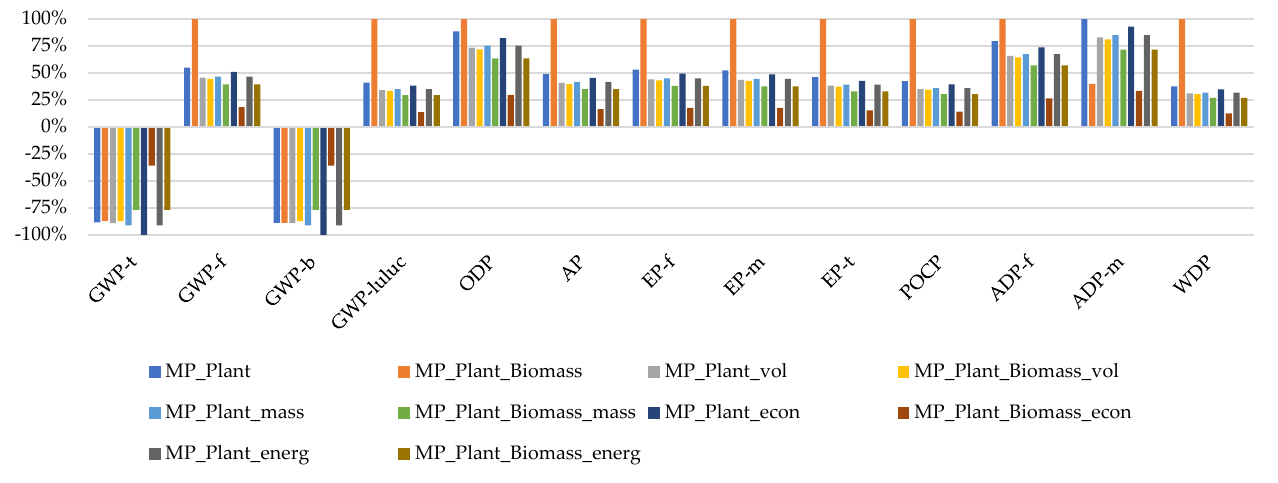
Figure 4. Relative environmental impacts of biomass and roundwood from Euc_Plant scenario.